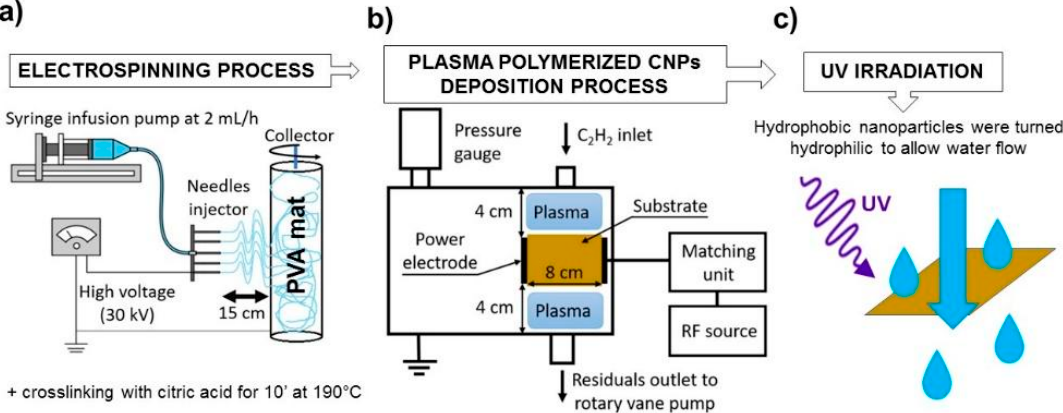
Figure 1. Schematic representation of the manufacturing process of the amphiphilic membranes. ( a ) PVA electrospinning process. ( b ) Plasma polymerized CNPs deposition on PVA membrane ( c ) UV exposure of PVA-CNP membrane.